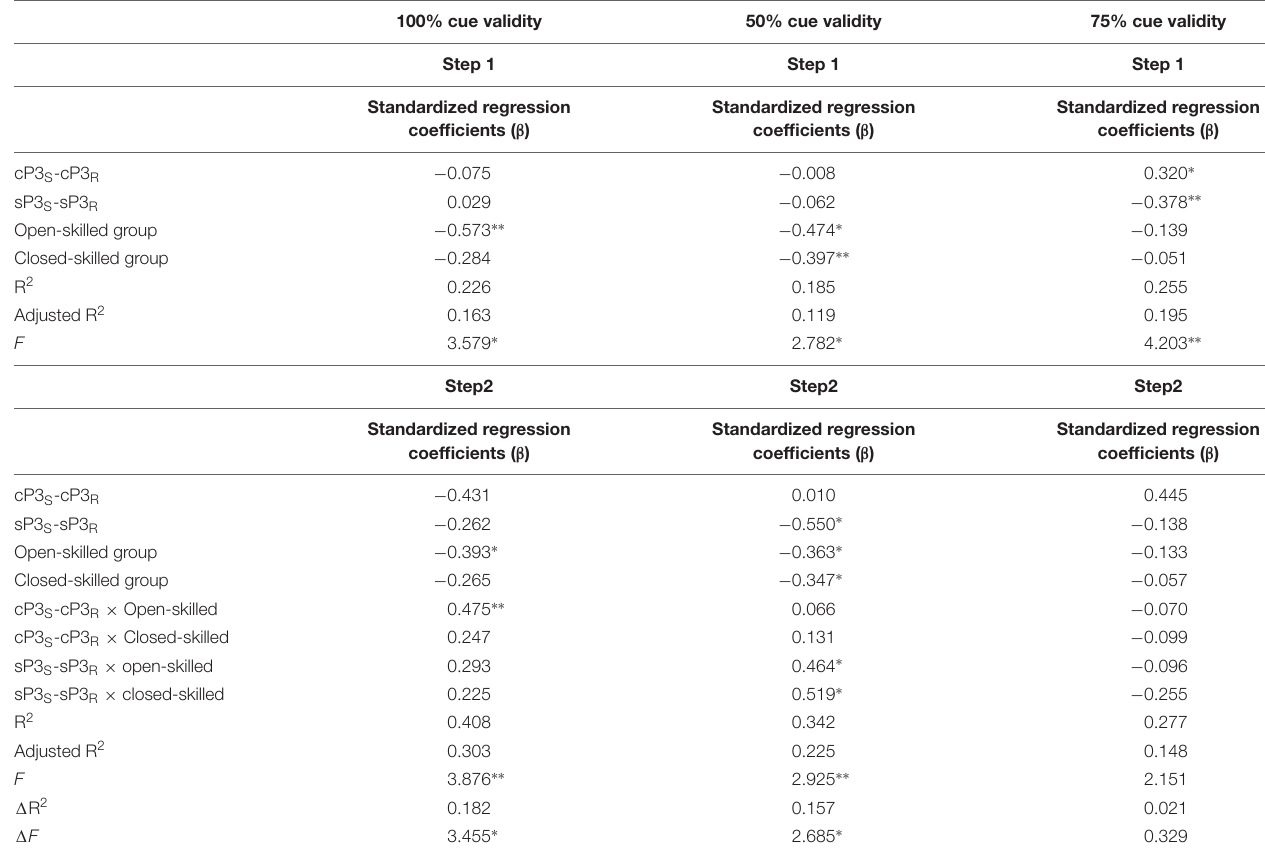
TABLE 2 | Results of hierarchical stepwise regression of amplitudes of the cue- and stimulus-locked P3 for predicting the switch cost of response times in the 100, 50, and 75% cue validity